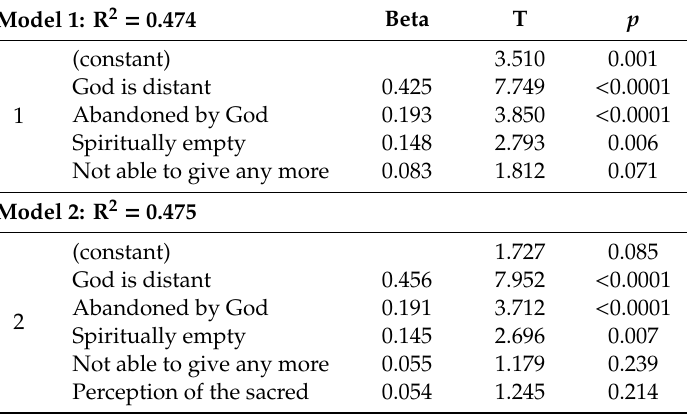
Table 5. Regression analyses among